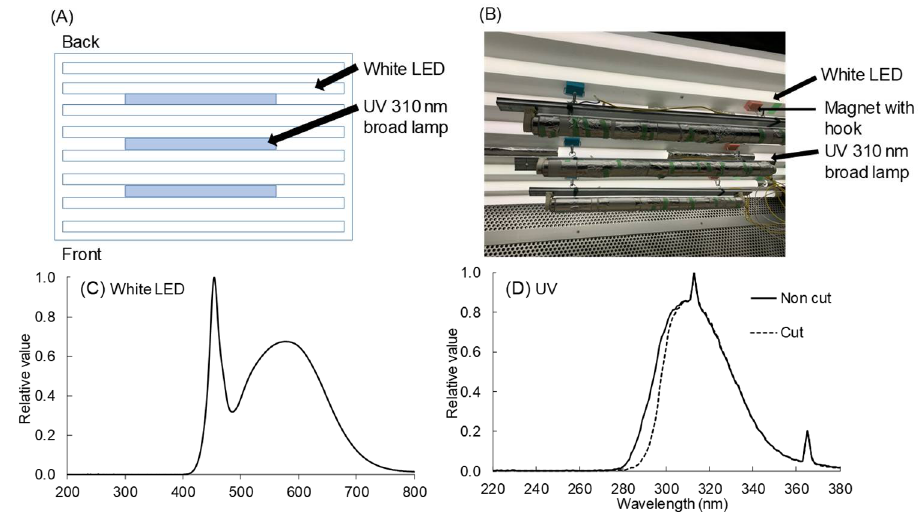
Figure 8. Schematic of plan of the lighting lack ( A ) and image used for this experiment ( B ). Spectral radiant flux distribution of white LEDs (LDL40S-N/19/21, Panasonic Co., Ltd.) ( C ) and UV irradia- tion with or without 300 nm short-cut filters between 220 and 380 nm ( D ). Irradiation energy was measured using a spectroradiometer (USR-45DA, Ushio Inc., Tokyo, Japan).